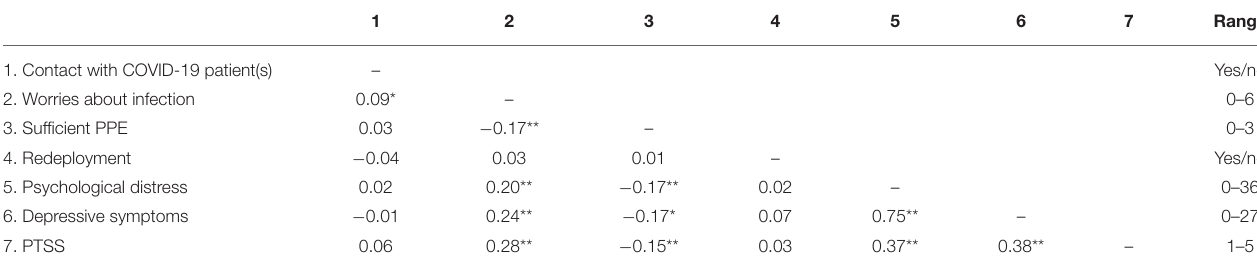
TABLE 3 | Intercorrelations and ranges for the main study variables.